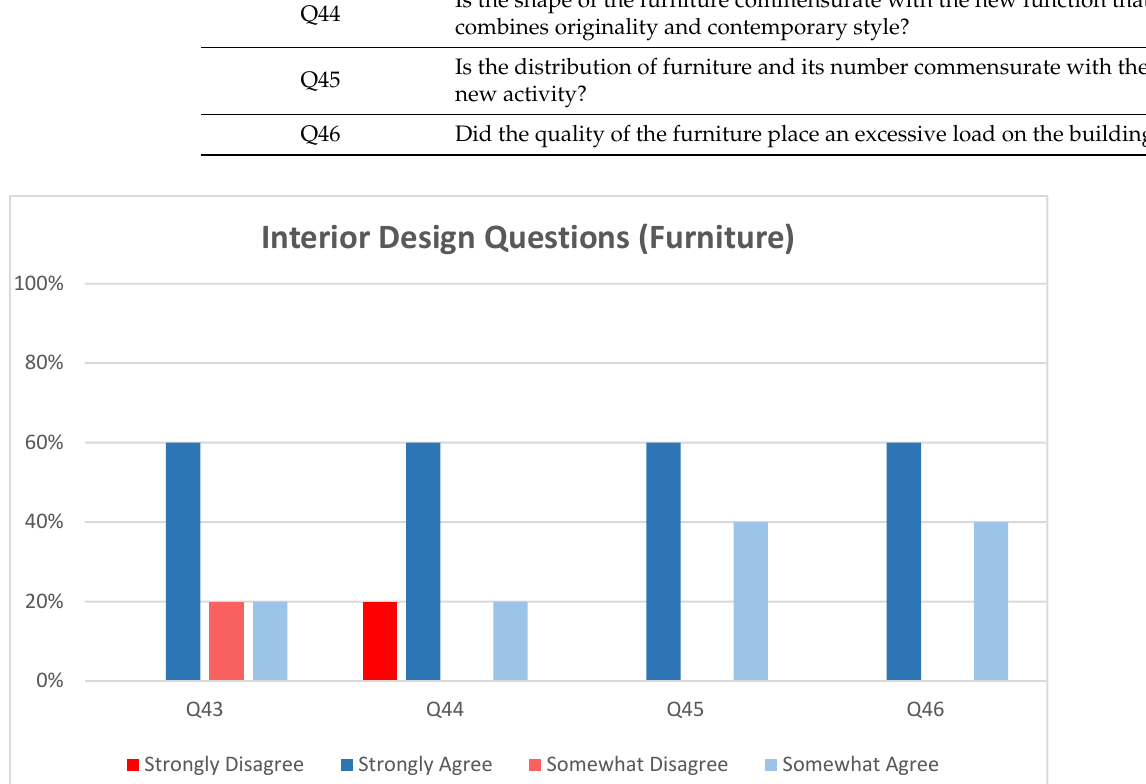
Table 9. Interior design questions (lighting) .